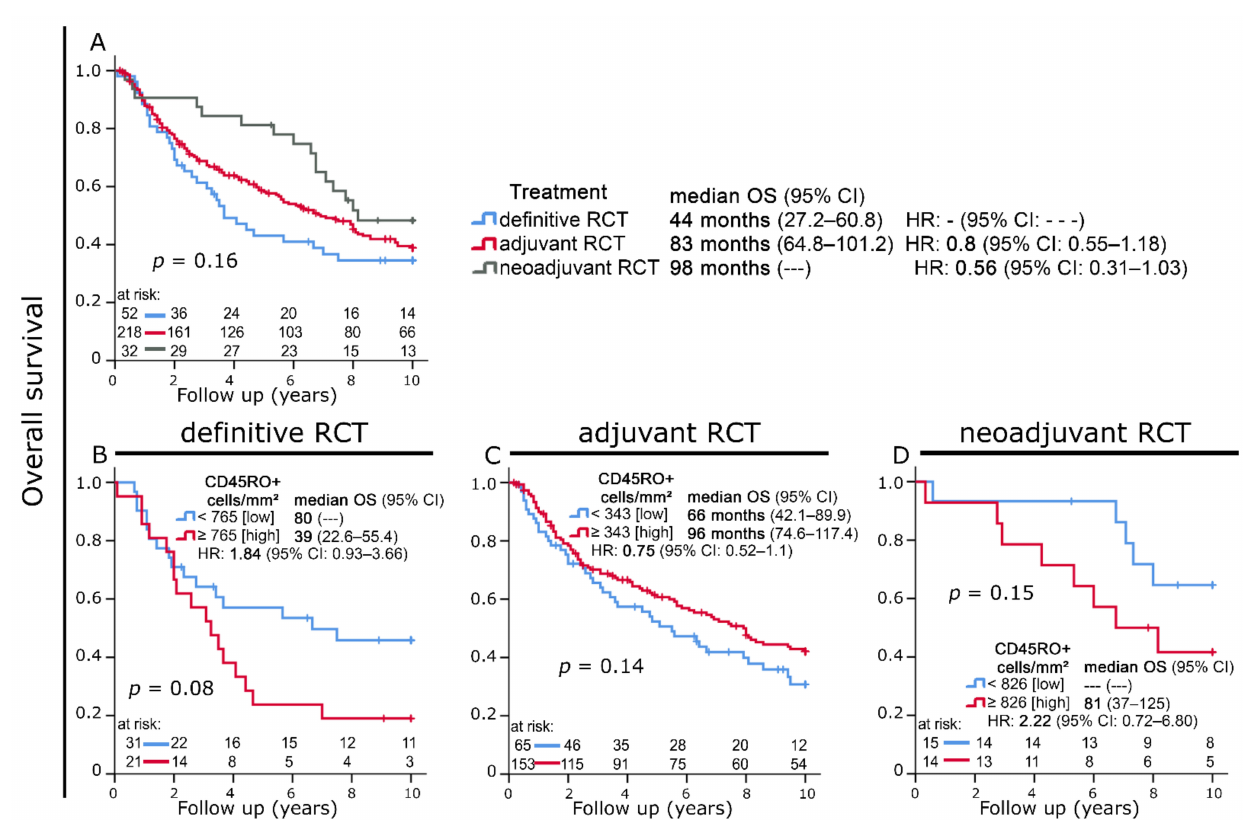
Figure 5. ( A ) Kaplan–Meier plot of overall survival according to treatment modality. ( B – D ) Kaplan– Meier plots of overall survival according to intraepithelial CD45RO+ cell densities in patients treated with ( B ) definitive radiochemotherapy (RCT), ( C ) adjuvant RCT, and ( D ) neoadjuvant